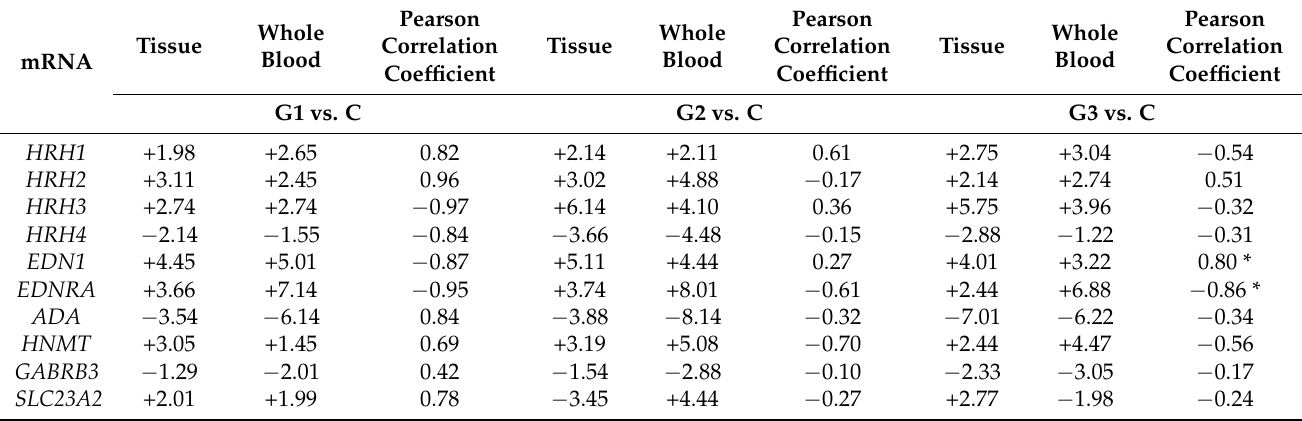
Table 4. Microarray profile of the expression of genes connected with the histaminergic system in G1–G3 samples of endometrioid endometrial cancer in comparison with the control. Pearson Whole Tissue Blood mRNA